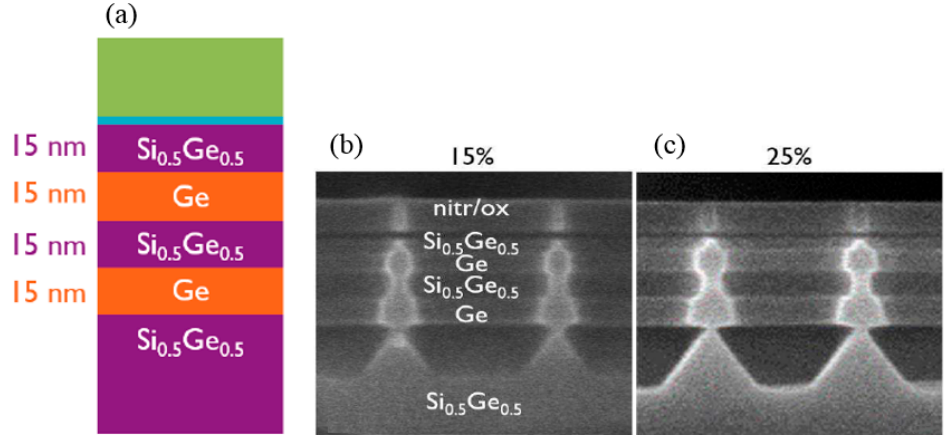
Figure 19. ( a ) Pictorial description of the Si 0.5 Ge 0.5 / Ge NW stacks used for the selective etch test and SEM images of Si 0.5 Ge 0.5 -Ge NWs after selective etch for 10 seconds in TMAH with a concentration of ( b ) 15% and ( c ) 25% for 45 and 55 nm wide fins